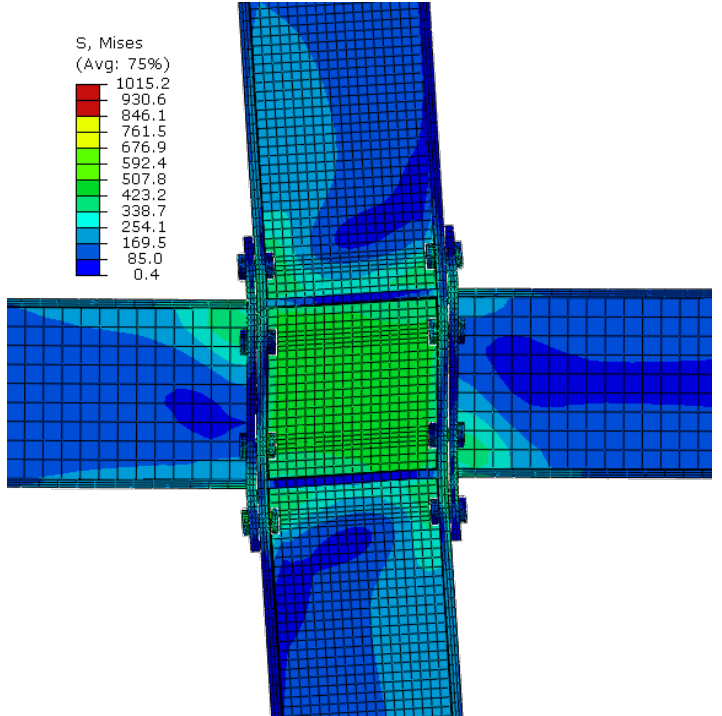
Figure 4. Prototype stress distribution.